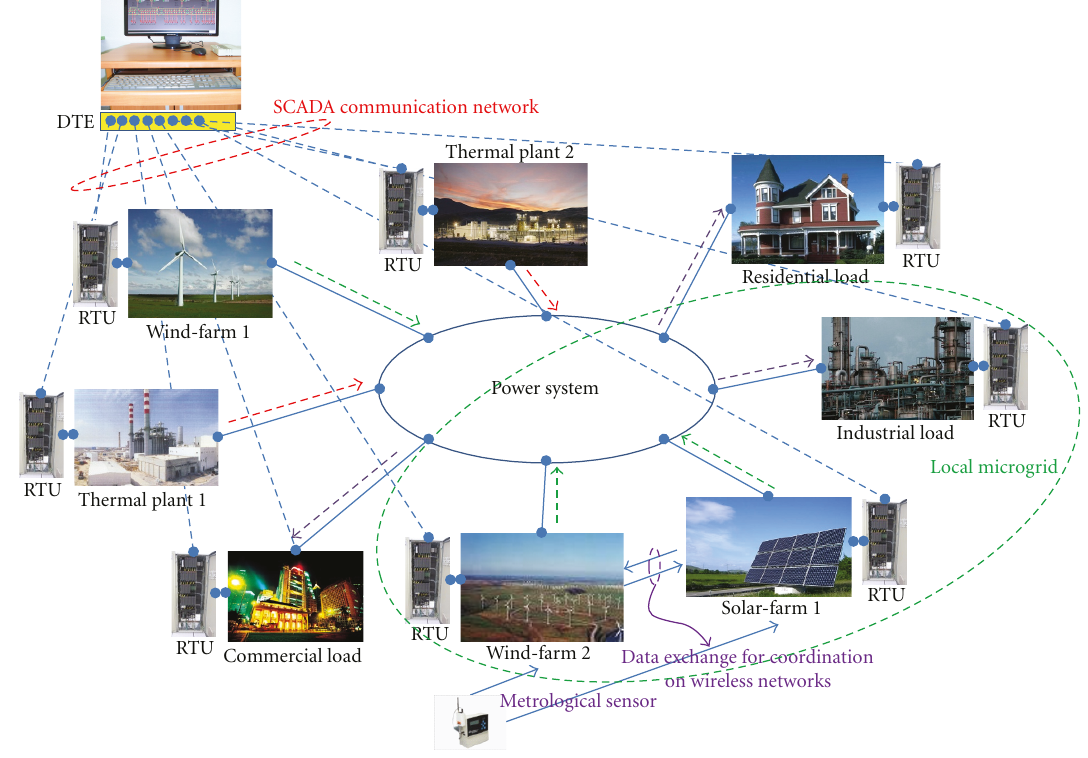
Figure 34: Data exchange for coordination on wireless